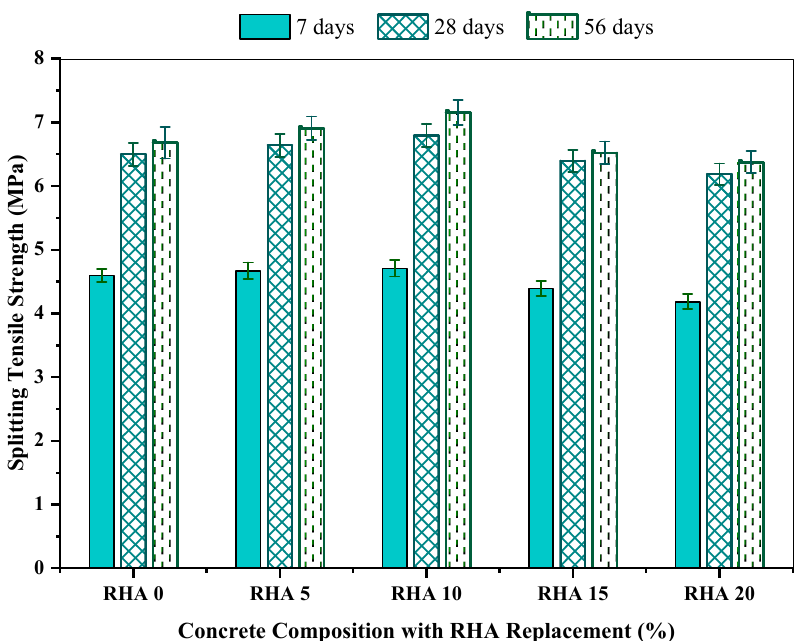
Figure 9. Splitting tensile strength of concrete incorporating RHA at 7, 28, and 56 days.